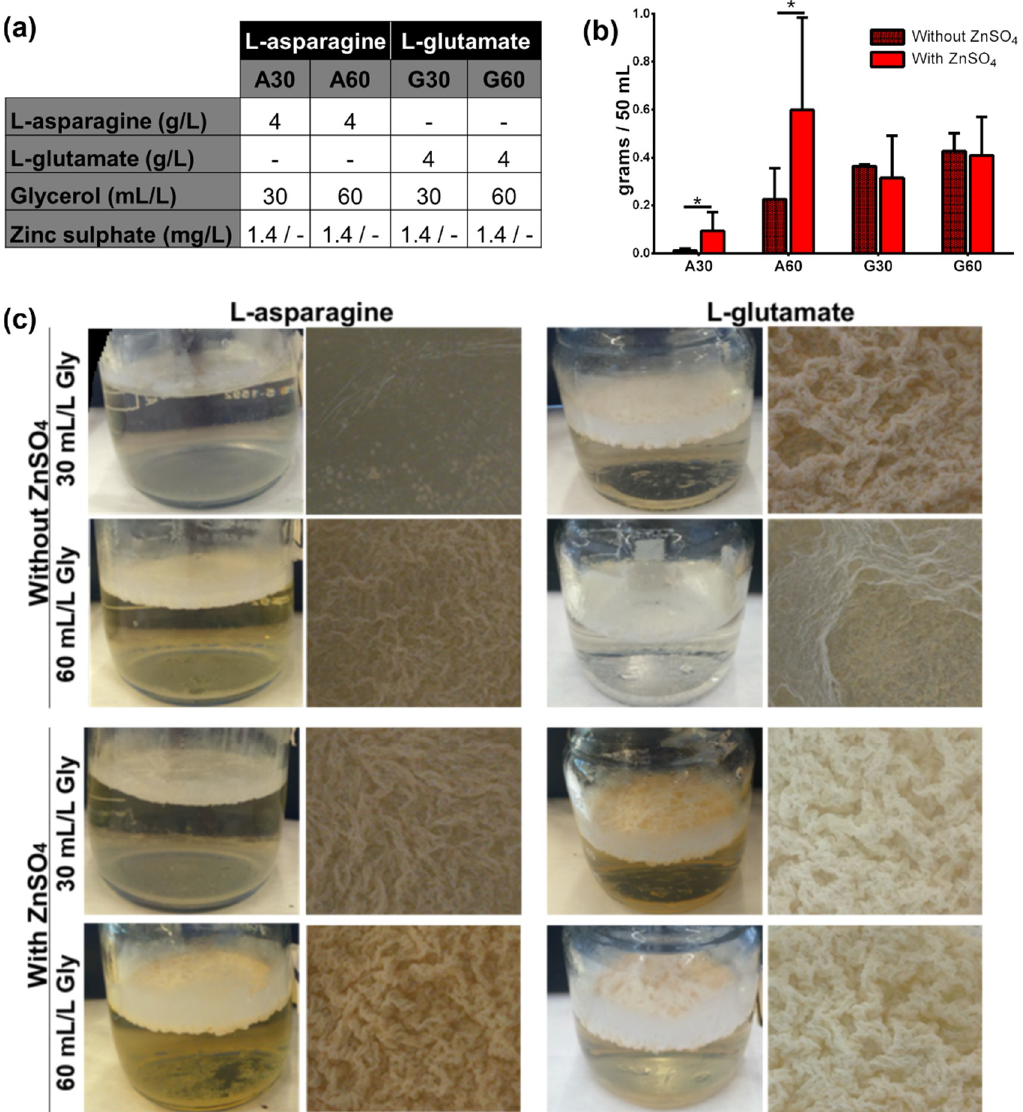
Figure 1. Influence of the presence of zinc sulphate in Sauton media on Mycolicibacterium brumae growth in pellicles. ( a ) Culture medium composition for evaluating the influence of ZnSO 4 on M. brumae growth. Each medium was evaluated in the presence of ZnSO 4 (1.4 mg/L) or in its absence (-); ( b ) biomass production of M. brumae pellicles grown in presence or absence of ZnSO 4 ; ( c ) macroscopic appearance. Data represent the mean ± standard deviation (SD) in each medium from at least three independent experiments. * p < 0.05 (Student’s t- test).